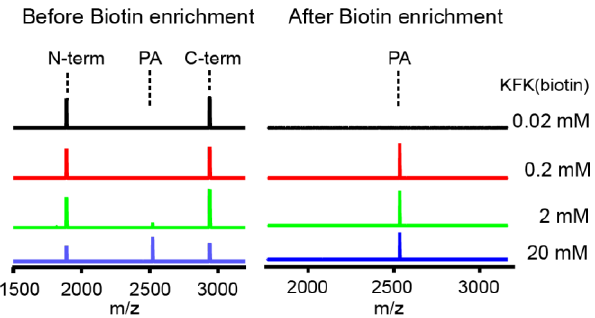
Figure 6. The cleavage reactions (10 µM DegP and 100 µM 18 – 58) with various concentrations of KFK(biotin) (0.02 – 20 mM) were analyzed by MALDI-TOF-MS before (left panel) and after (right panel) biotin enrichment via streptavidin-linked magnetic beads. Representative spectra are shown (n = 3).